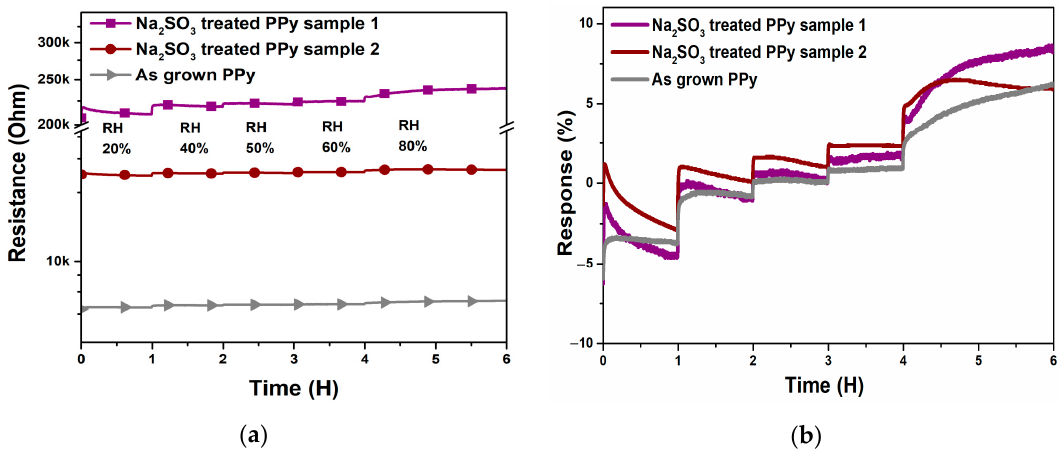
Figure 10. Ammonia sensing test: ( a ) Response and ( b ) calibration curve of as grown PPy sensor and PPy sensors after reduction treatments in Na 2 SO 3 10 wt% solution in demineralized water.